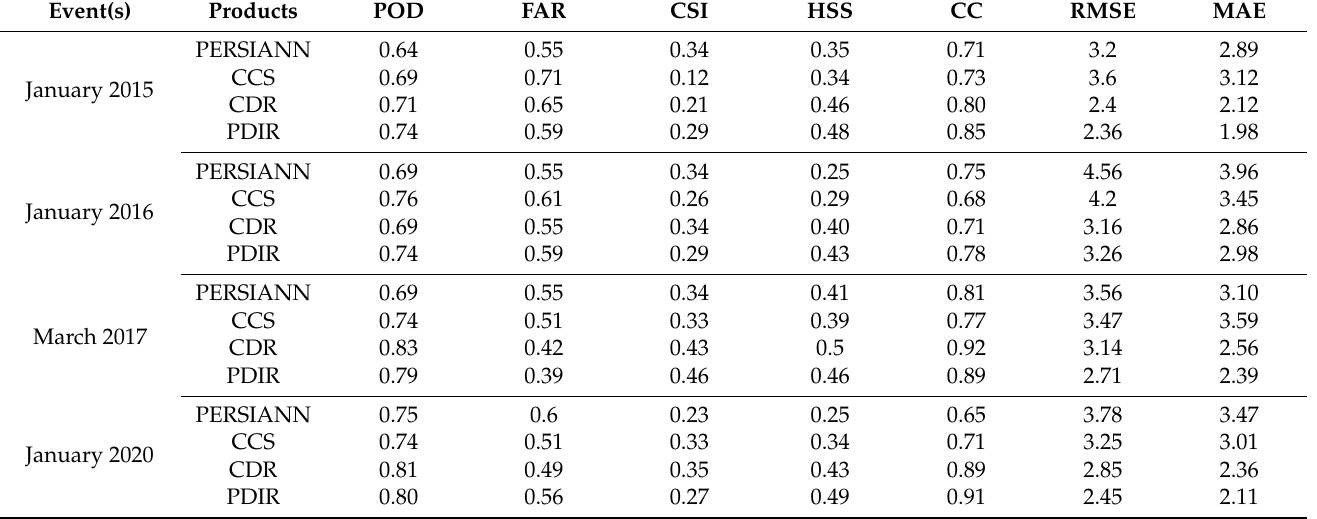
Table 5. Statistical and contingency measures for the four selected rainfall events and corresponding satellite products. Mean values are shown for POD, FAR, CSI, HSS, CC, RMSE, and